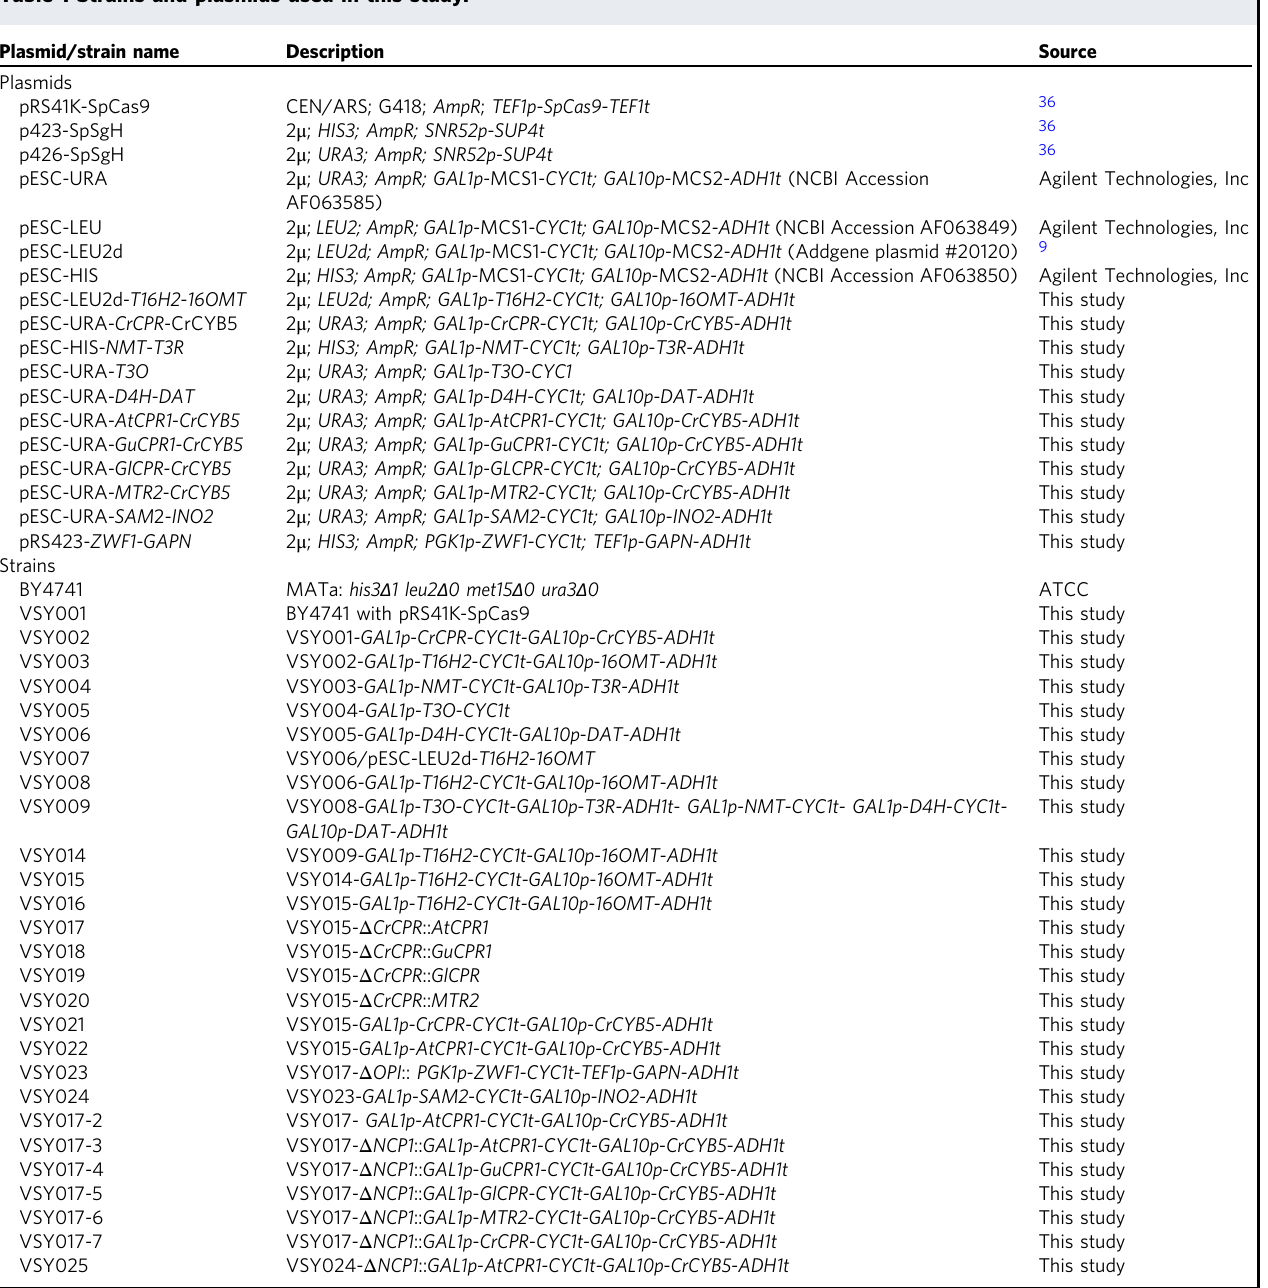
Table 1 Strains and plasmids used in this